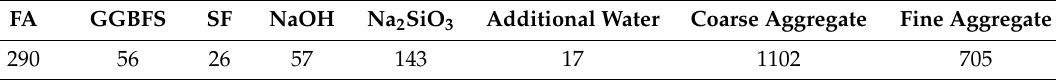
Table 2. Mix Design of the AAC (kg / m 3 ).